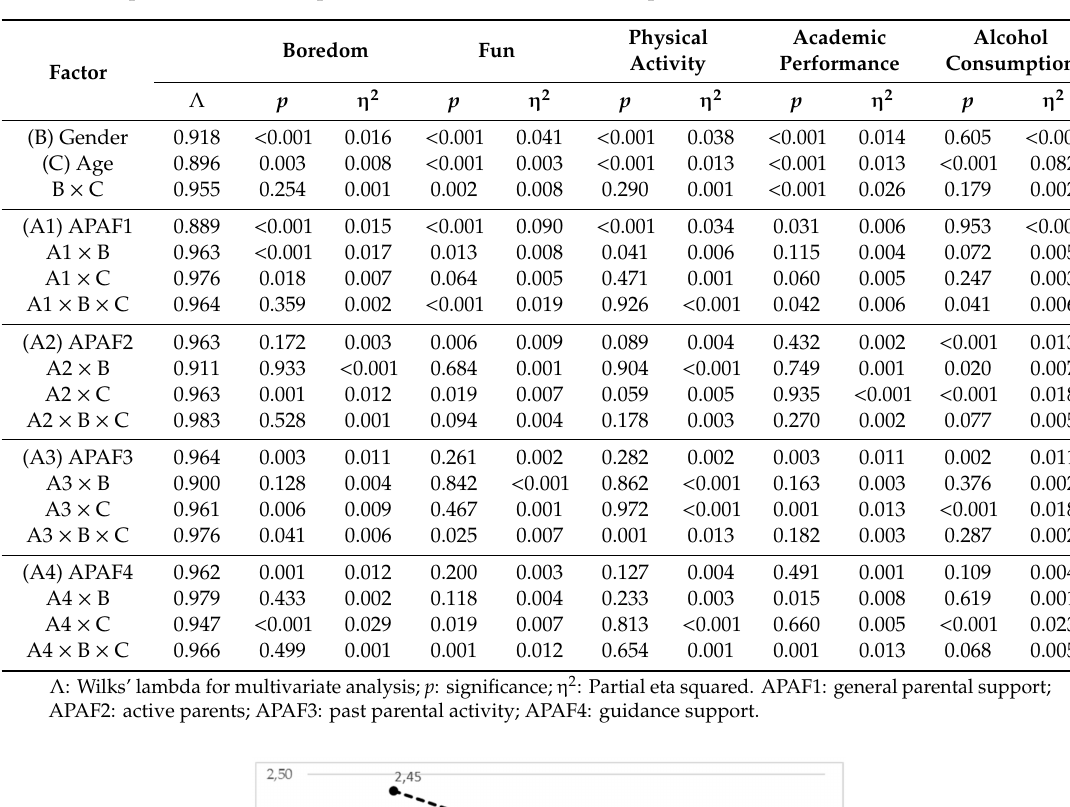
Table 2. Multivariate analysis of APAF factors, gender and age and the dependent variables of boredom, fun, PA practice, academic performance and alcohol consumption.